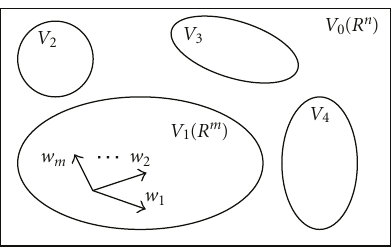
Figure 1: Linear feature extraction: from the subspace viewpoint.